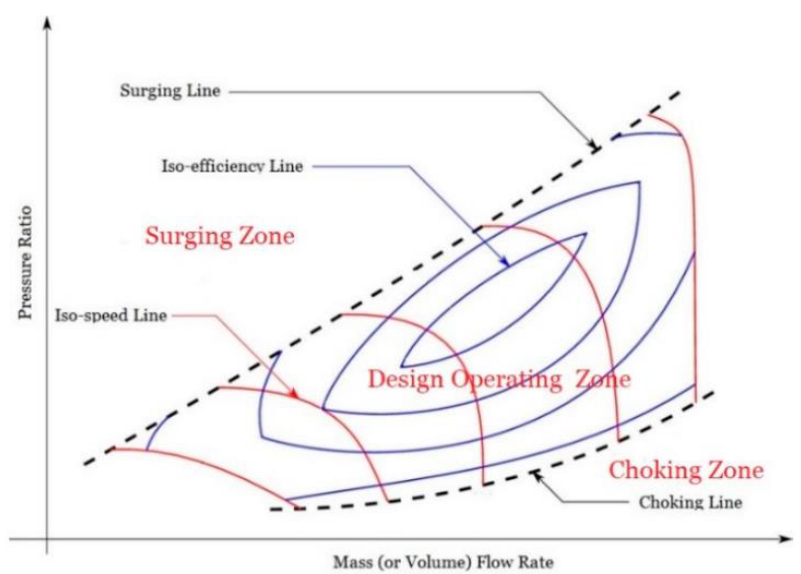
Figure 2. Compressor performance map.